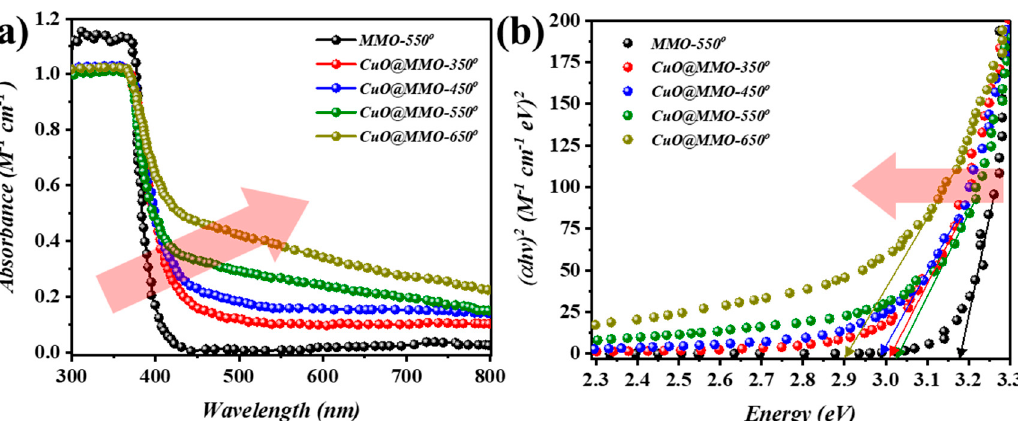
Figure 2. ( a ) Ultraviolet-visible light absorption spectra and ( b ) evaluated band gap of annealed